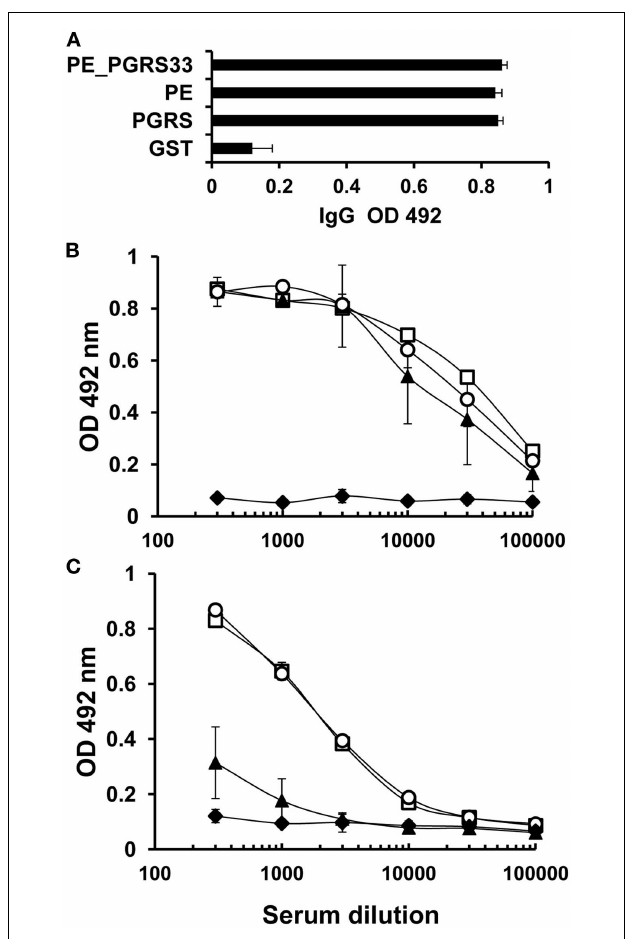
FIGURE 1 | Humoral immune response to PE_PGRS33, PGRS, and PE in immunized mice. BALB/c mice were immunized with PE_PGRS33 and sera were collected 15days after the last immunization. IgG (A) , IgG1 (B) , and IgG2a (C) responses to PE_PGRS33 ( (cid:3) ), PE ( (cid:78) ), PGRS ( (cid:13) ), and the control protein GST ( (cid:7) ), were evaluated by ELISA assay. For total IgG determination, each serum was diluted 1:100 and for IgG1 and IgG2a determination, mice sera were diluted as indicated in the figure. Bars (A) and datum points (B,C) are the average readings ± SD of data from four mice in the group, and the results showed are representative of three independent experiments.